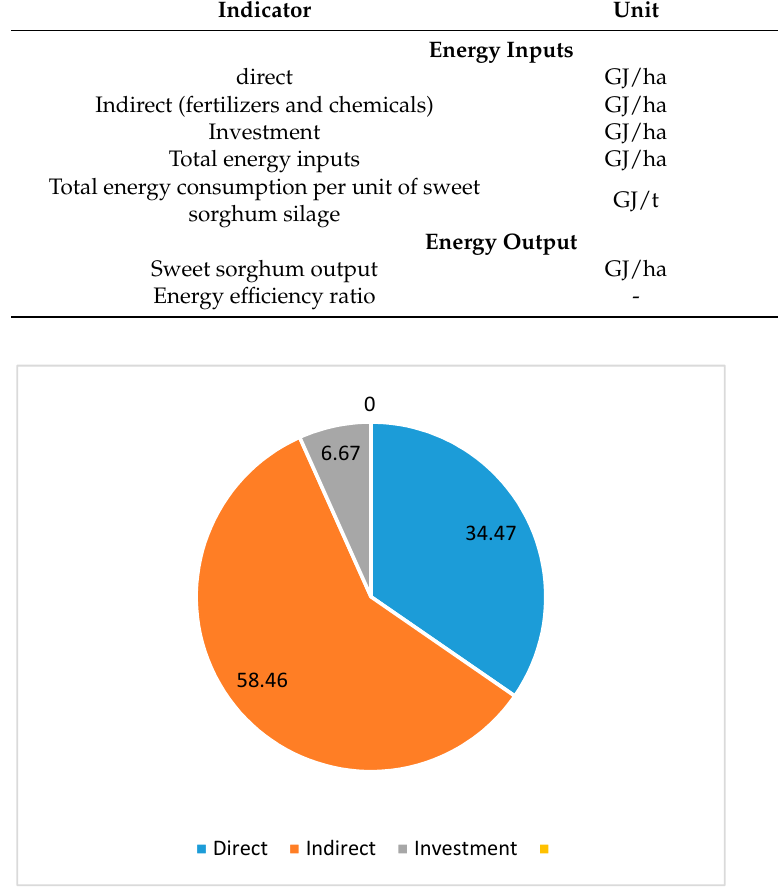
Figure 7. The structure of energy inputs, %.